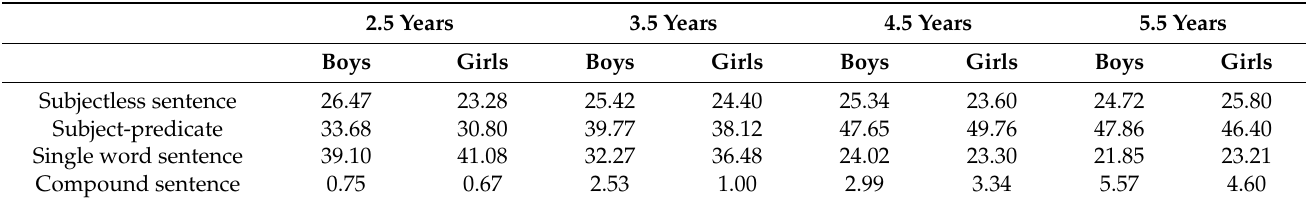
Table 4. Sentence structures by age and gender groups